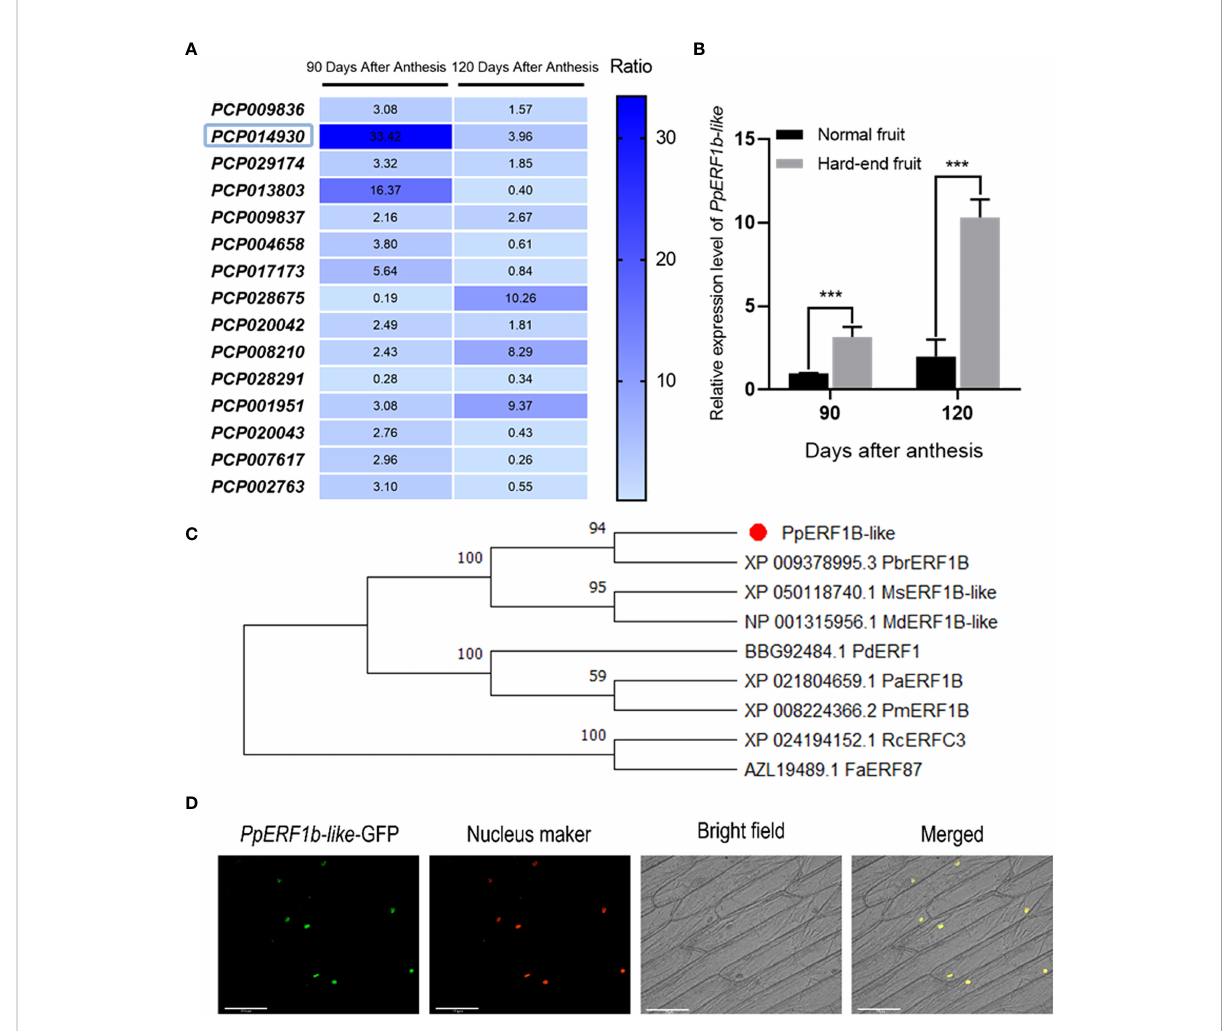
FIGURE 2 Transcriptome sequencing and subcellular localization of PpERF1b-like . (A) Screening of PpERF1b-like by transcriptome sequencing. (B) The relative expression level of PpERF1b-like in normal and hard-end fruit of pear ‘ Whangkeumbae ’ at 90 and 120 days after anthesis. Data are given as mean ± SD (n = 4). The asterisk represents a signi fi cant difference (*** p < 0.001; Student ’ s t-test ). (C) Phylogenetic analysis of PpERF1b-like . PpERF1b-like protein sequences (indicated by red fi gure) were aligned with ERFs from P. bretschneideri Rehd (Pbr), Malus sylvestris (Ms), M. domestica (Md), P. dulcis (Pd), P. avium (Pa), P. mume (Pm) and Rosa chinensis (Rc). The phylogenetic tree was constructed using the neighbor- joining method with 1000 bootstrap replications in MEGA 11 software. Sequences were obtained from the National Center for Biotechnology Information nucleotide database (http://www.ncbi.nlm.nih.gov/nucleotide/). Bootstrap values are indicated above the branches. (D) Subcellular localization of PpERF1b-like -green fl uorescent protein (GFP) fusion protein was determined by infecting onion epidermal cells and imaged under a EVOS FL Auto 2 imaging system. Scale bars = 125 m